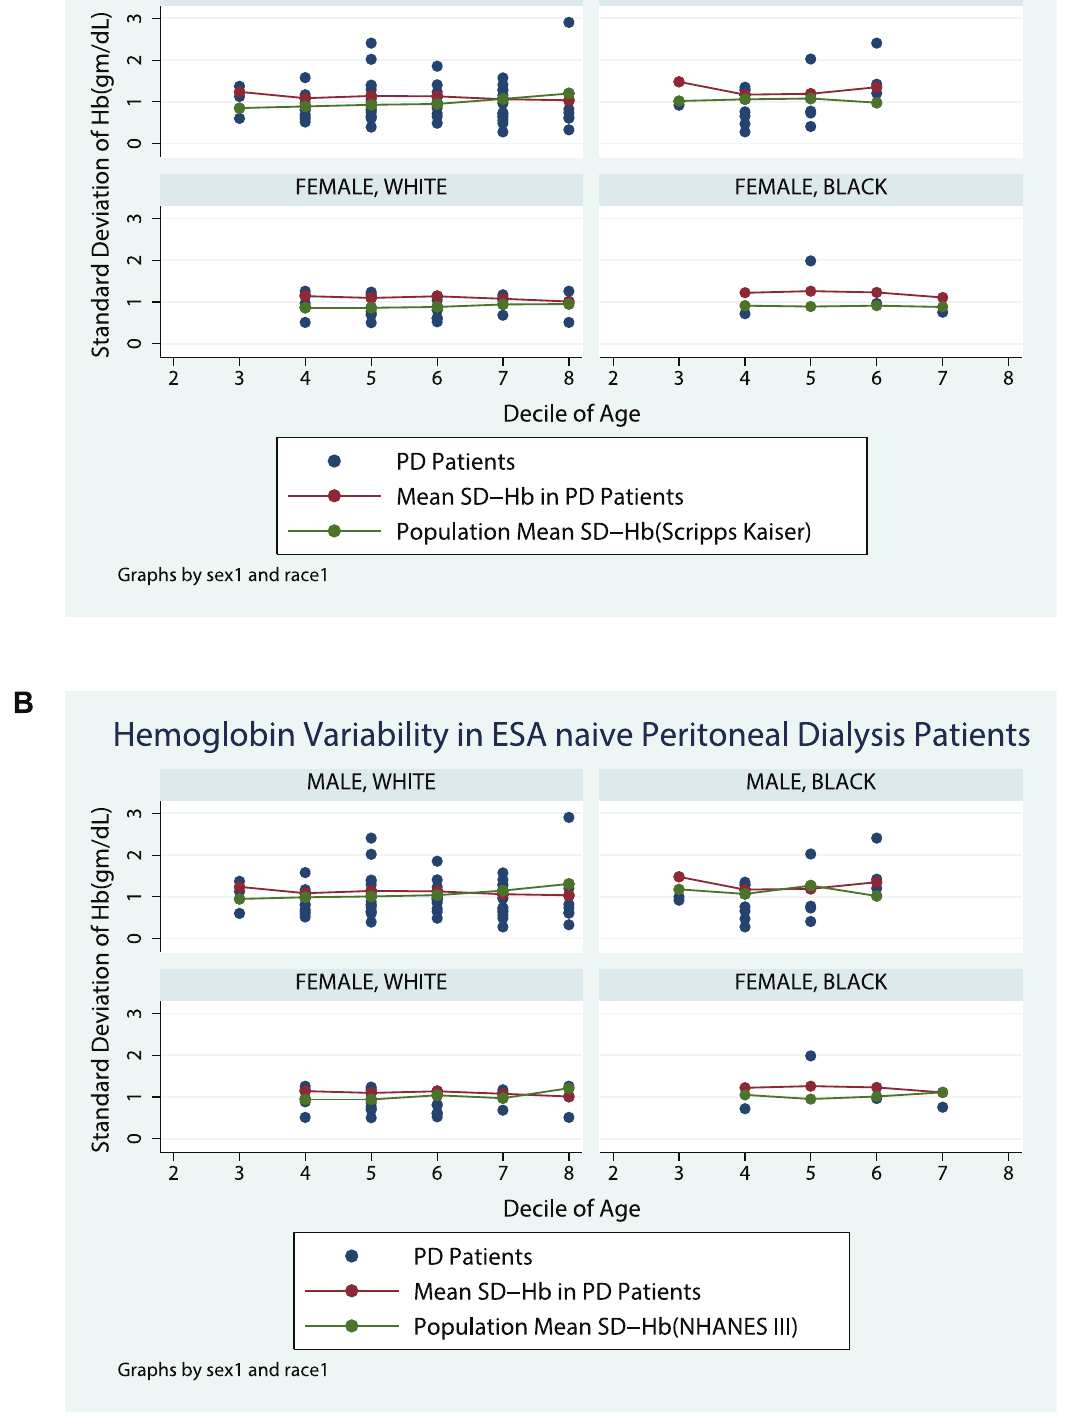
Figure 1. Hemoglobin Variability in ESA naı¨ve Peritoneal Dialysis Patients.